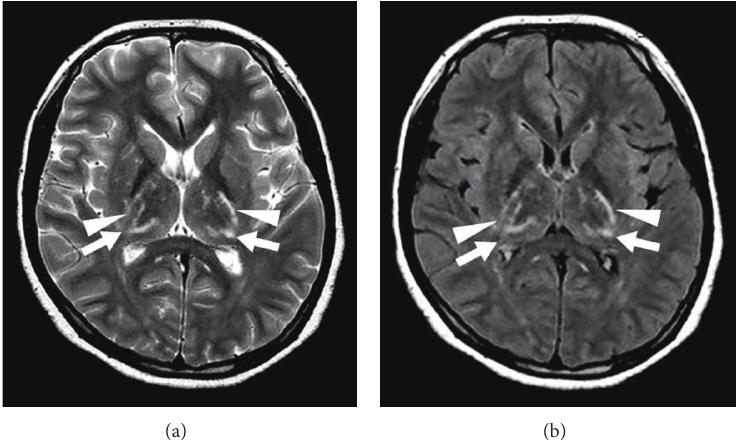
Figure 20: A patient with Mycoplasma pneumoniae-related acute necrotizing encephalitis involving symmetrically the posterior part of the internal capsule (arrowheads) and the posterolateral portion of the thalamus (arrows) on both sides, seen as hyperintensity on both T2-weighted (a) and FLAIR (b)